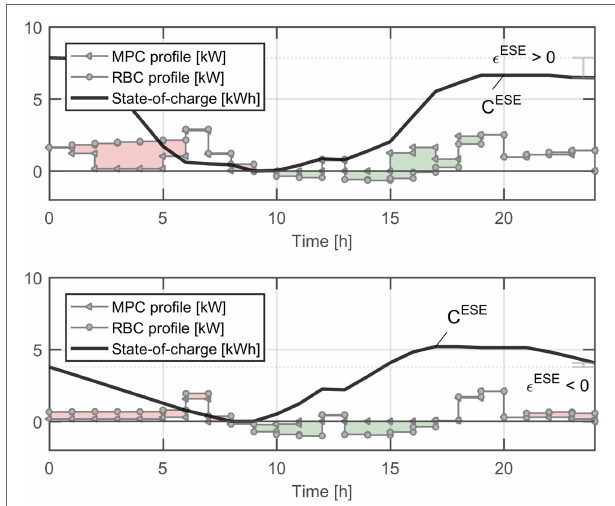
FIGURE 7 | Building net power profiles and state of charge of the virtual battery (ESE) during typical spring days. The colored areas represent charging (green) and discharging (red) periods,